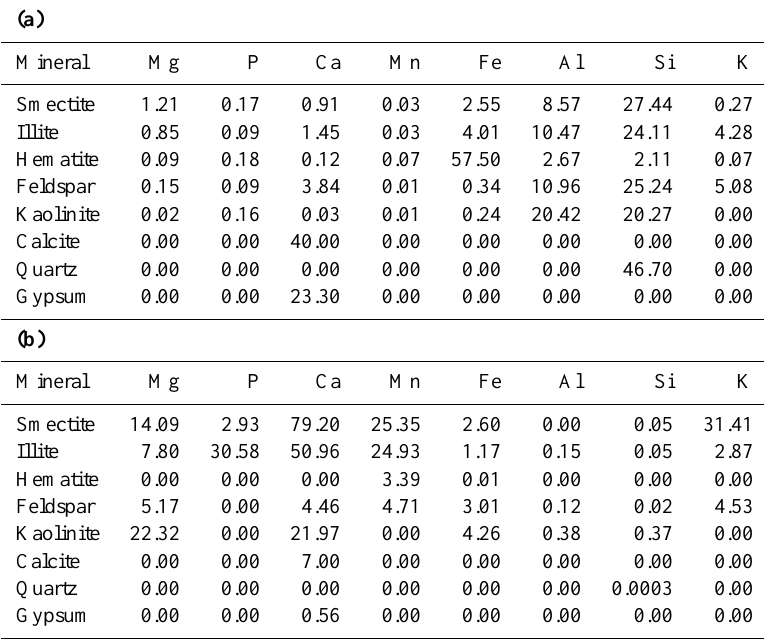
Table 1. (a) Generalized mineral compositions (%) applied in this study. (b) Elemental solubility as a percentage of the element contained in the minerals